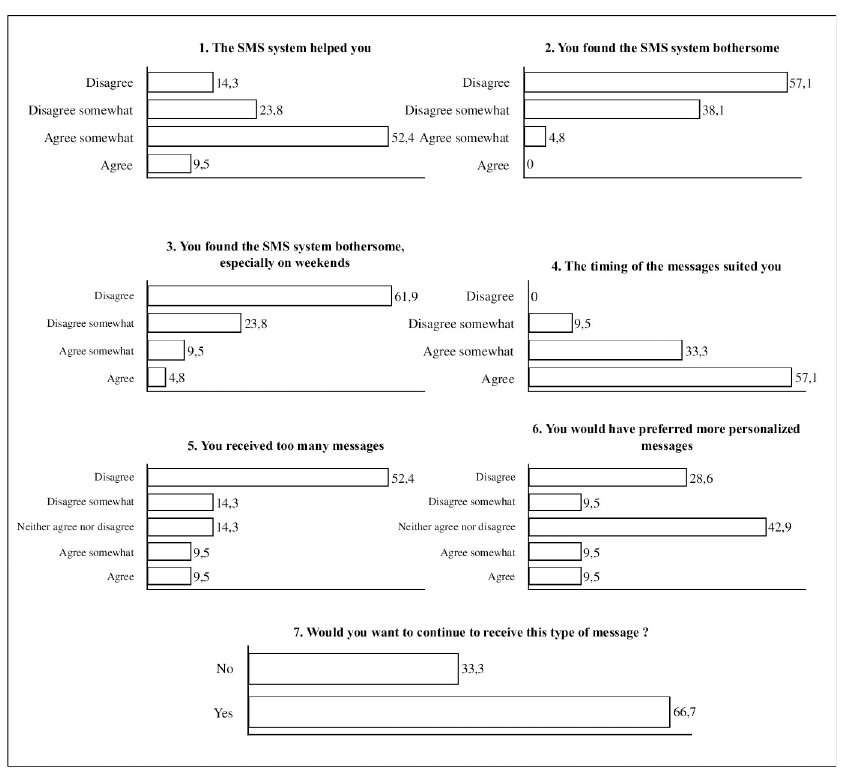
Fig 2. Satisfaction questionnaire completed by 21 patients randomized in the intervention arm (SMS arm). The data are percentages.